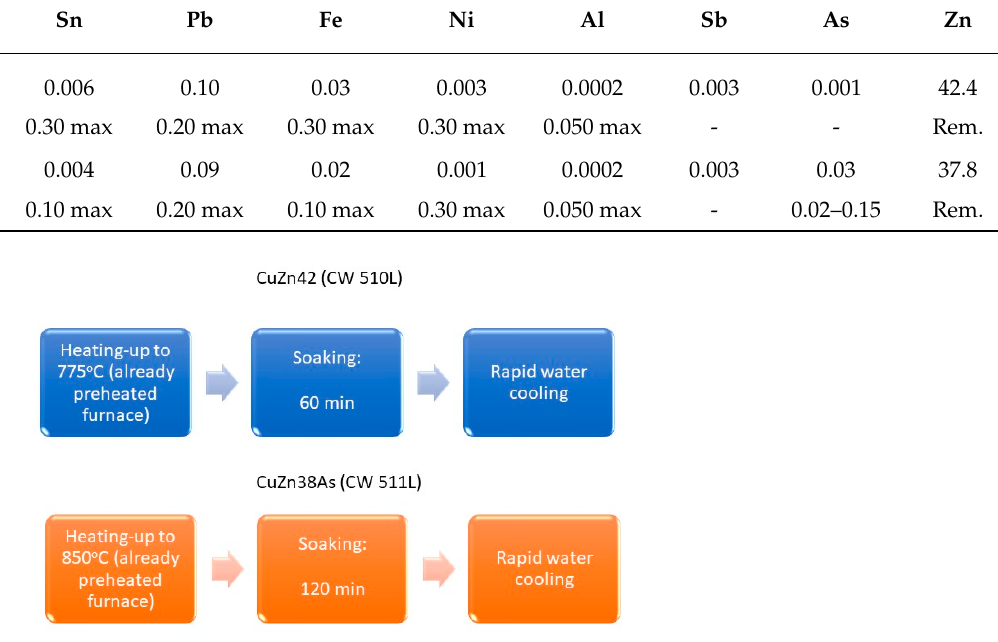
Figure 1. Simple schematic diagram showing the performed heat treatment processes (blue blocks for CuZn42 and orange blocks for CuZn38As alloy samples). Heat treatment conditions—CuZn42: 775 °C for 60 min followed by water quenching; CuZn38As: 850 °C for 120 min followed by water quenching.